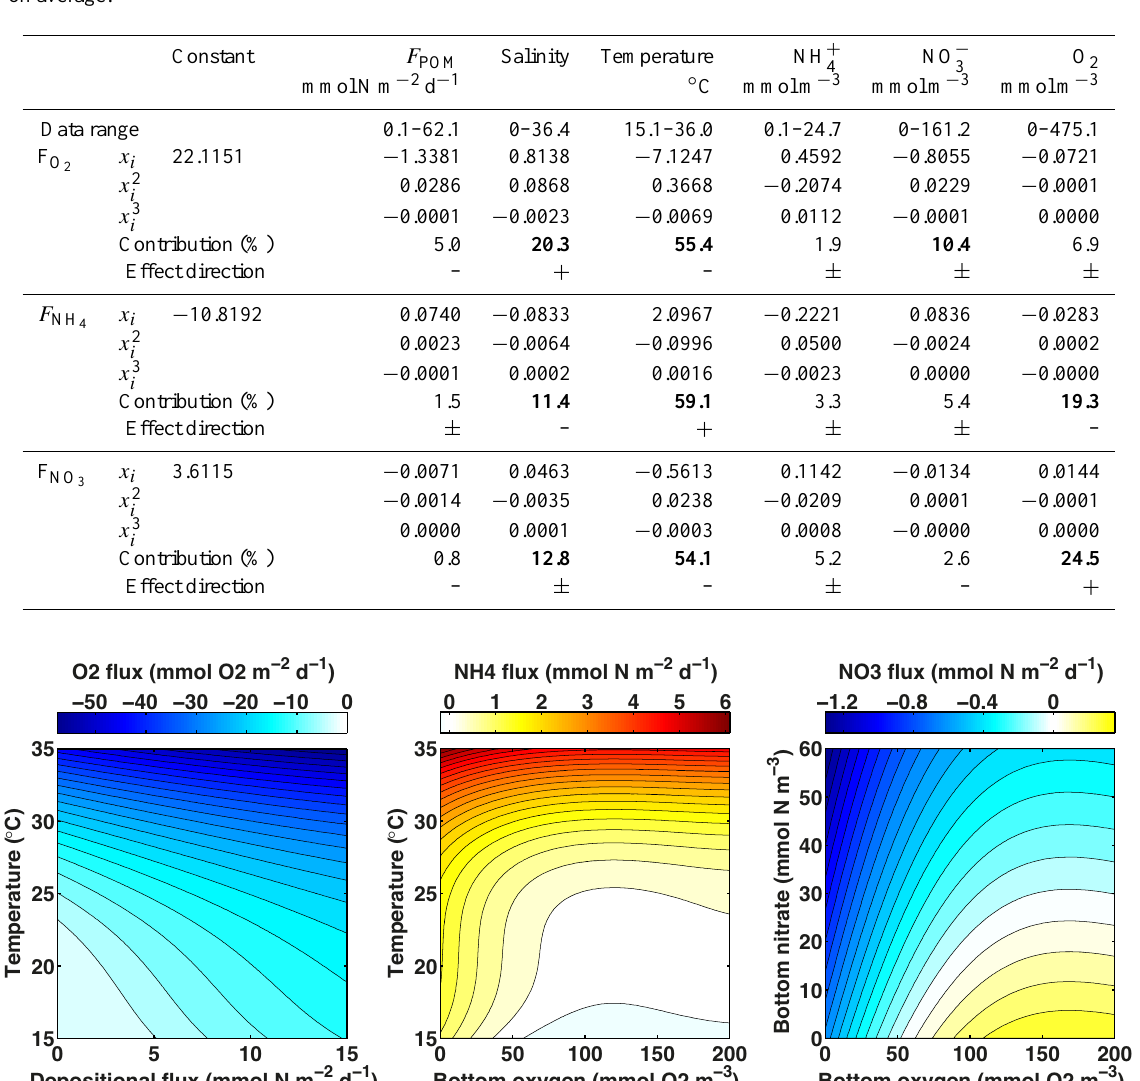
Table 4. Meta-model coefficients for sediment O 2 consumption ( F O is given in Eq. (4). For each flux, the average contribution of each input variable is indicated as well as the dominant direction of its effect. A positive effect promotes a weaker flux into the sediment or a larger flux to the water column (depending on the direction of the flux), whereas a negative effect leads to a larger sink into the sediment or a weaker flux to the water column. ± indicates that the effect’s direction varies as a function of the variable. The contributions were calculated from standardized coefficients. Bold values indicate variables contributing >10% on average.